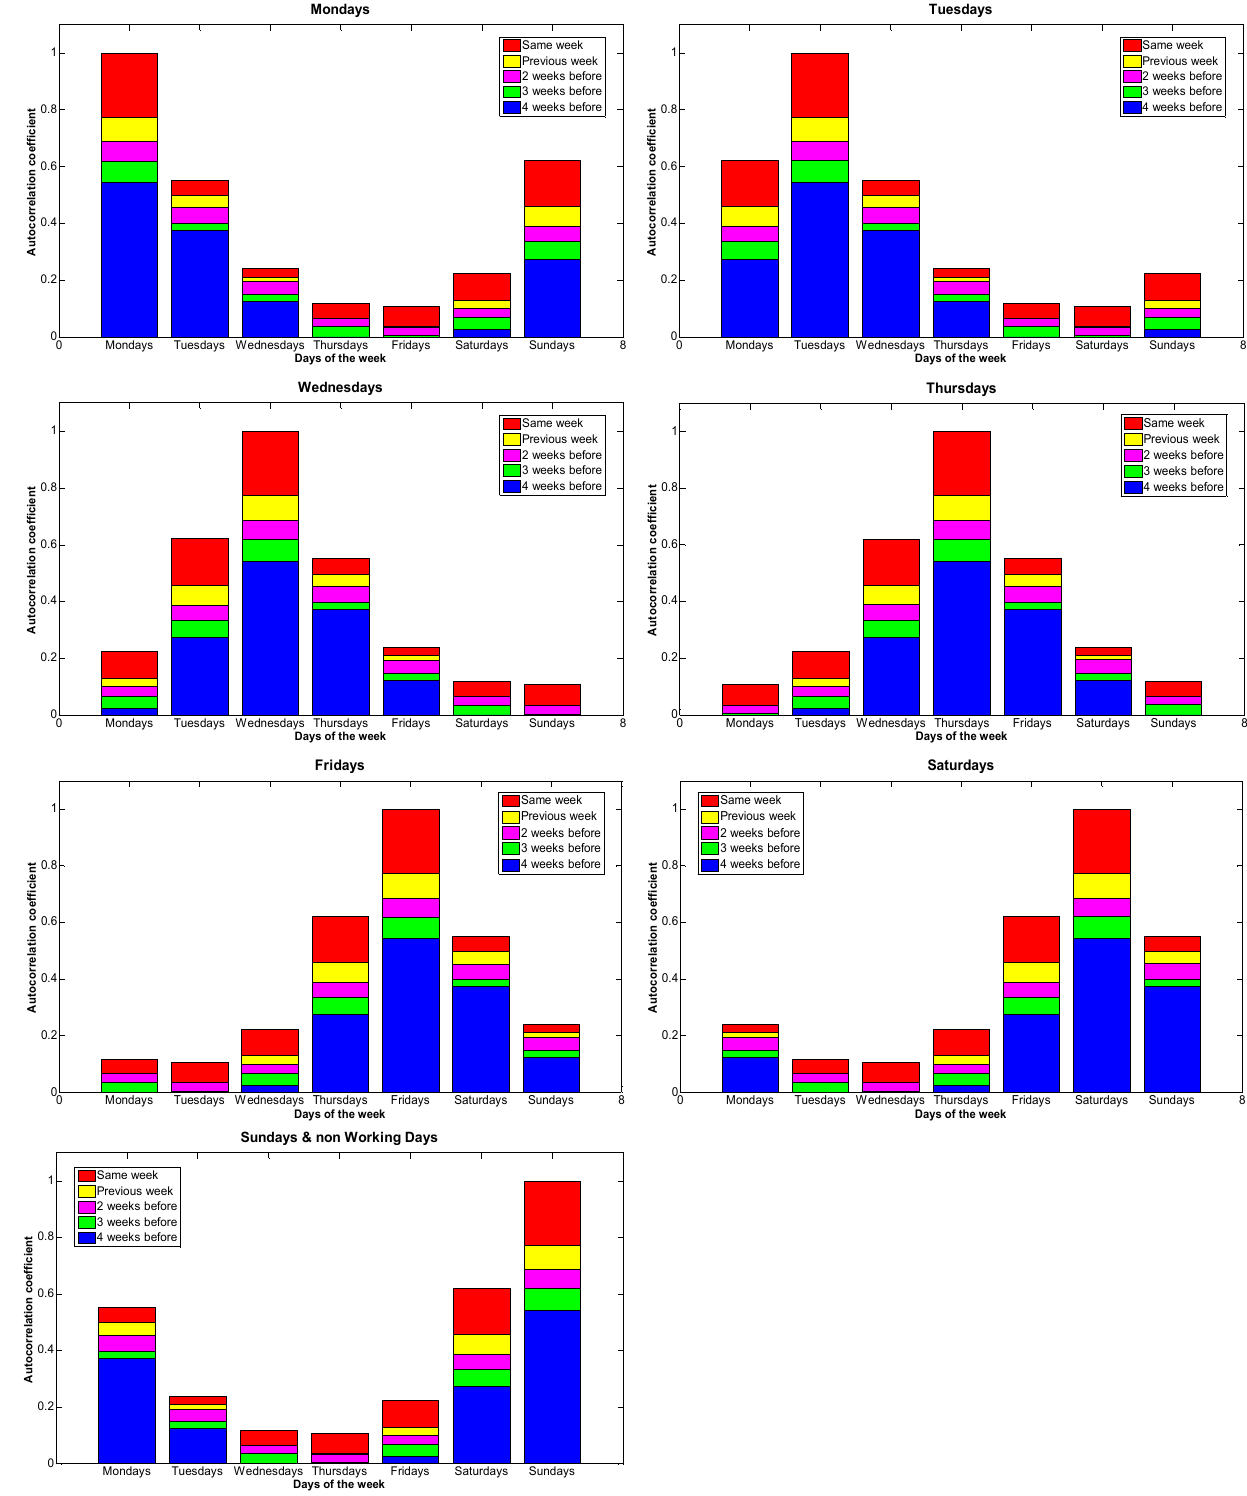
Figure 2. Mean autocorrelation coefficients for the aggregated load, arranged by day of the week. (Note: Each bar represents the autocorrelation coefficient of every week day, and each bar portion represents one week delay